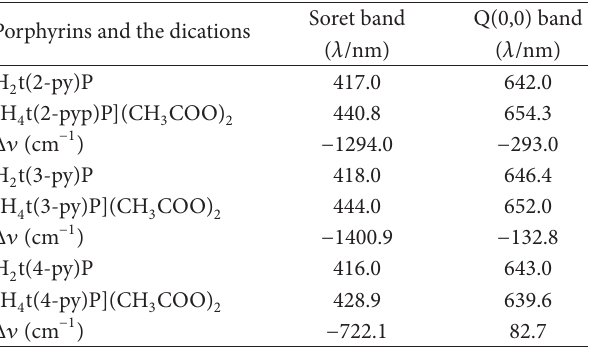
a See the footnotes of Table 2. b Excess amounts of acetic acid was used to complete the reaction (see Section T 6: UV-vis spectral data for protonation of H different acids in methanol. Porphyrins and the